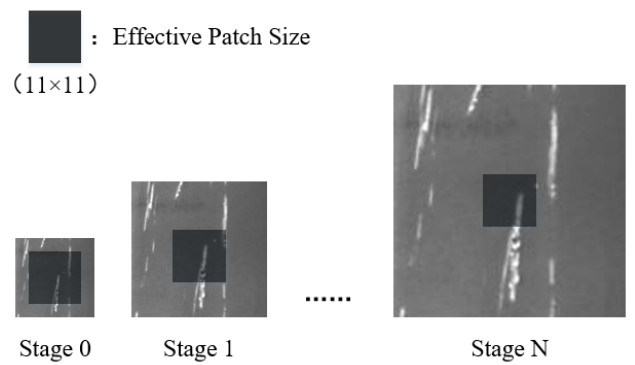
Figure 2. Receptive fields of images with different sizes.